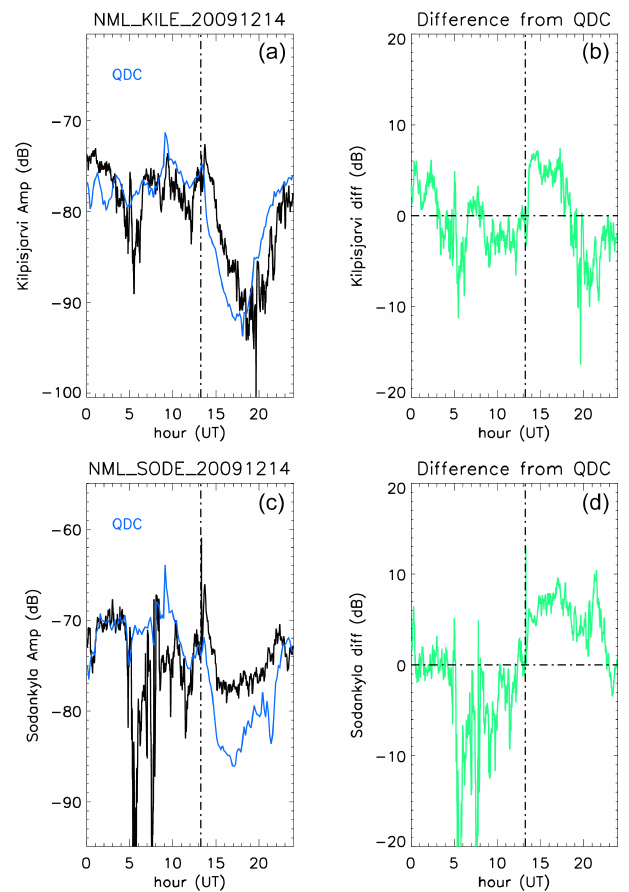
Figure 3. The amplitude variation in the NML VLF transmitter (LaMoure, North Dakota; 25.2kHz) received at two receivers in Finland on 14 December 2009. Panels (a) and (b) show data from Kilpisjärvi, while (c) and (d) show data from Sodankylä. A repre- sentative quiet day curve for each site (QDC; blue line) is shown using data from 11 December 2009. The difference in amplitude between the signal from 14 December 2009, and the QDC is shown in the right-hand panels. A vertical dash-dotted line indicates the start of a perturbation at